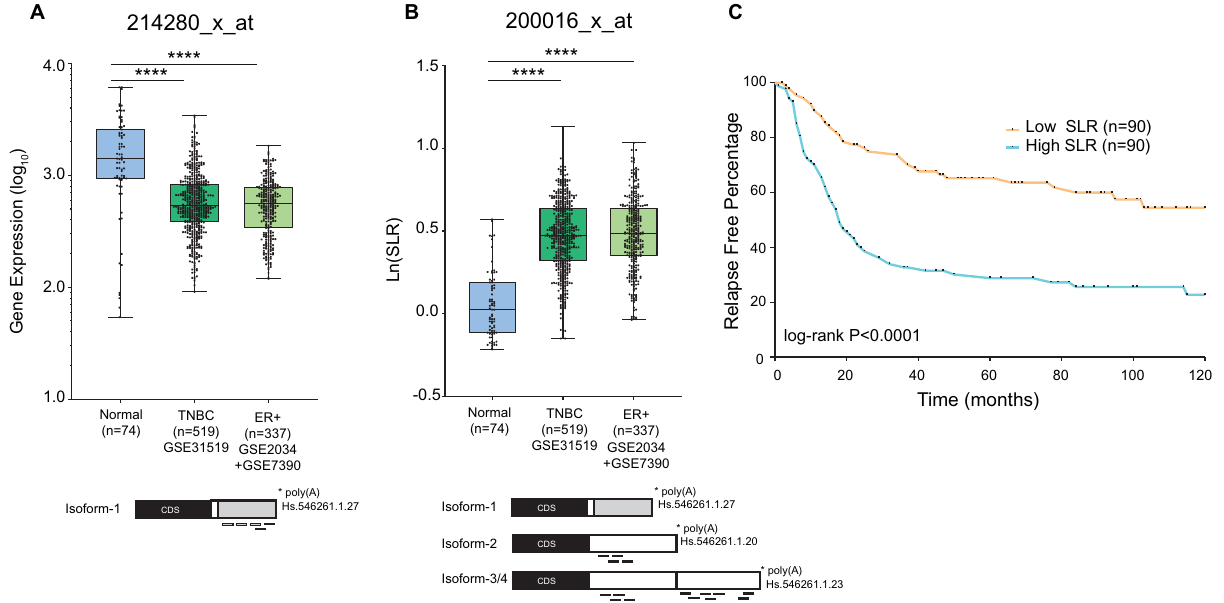
Figure 1. Isoform level expression of HNRNPA1 . ( A ) HNRNPA1 Isoform-1 expression in breast cancer patients compared with normal breast tissue (****p < 0.0001, unpaired t-test) in GSE31519, GSE2034, and GSE7390 datasets. Positions of Affymetrix distal probes (214280_x_at) recognizing only Isoform-1 are shown. ( B ) SLR values (Isoform 2 + 3 + 4/Isoform 3 + 4) of HNRNPA1 in breast cancer patients compared with normal breast tissue (****p < 0.0001, unpaired t-test) in GSE31519, GSE2034, and GSE7390 datasets. Positions of Affymetrix distal probes (200016_x_at) recognizing Isoform-2,3,4 are shown. ( C ) High expression (of Isoform-2, 3, and 4) correlates with poor relapse-free survival in TNBC patients. GSE31519 dataset was grouped according to the top 25% (High) and bottom 25% (Low) expressing patients. Expression values are based on proximal probes of 200016_x_at, excluding levels of Isoform-1. Hazard ratio (95% CI) is 2.709 (log-rank p <